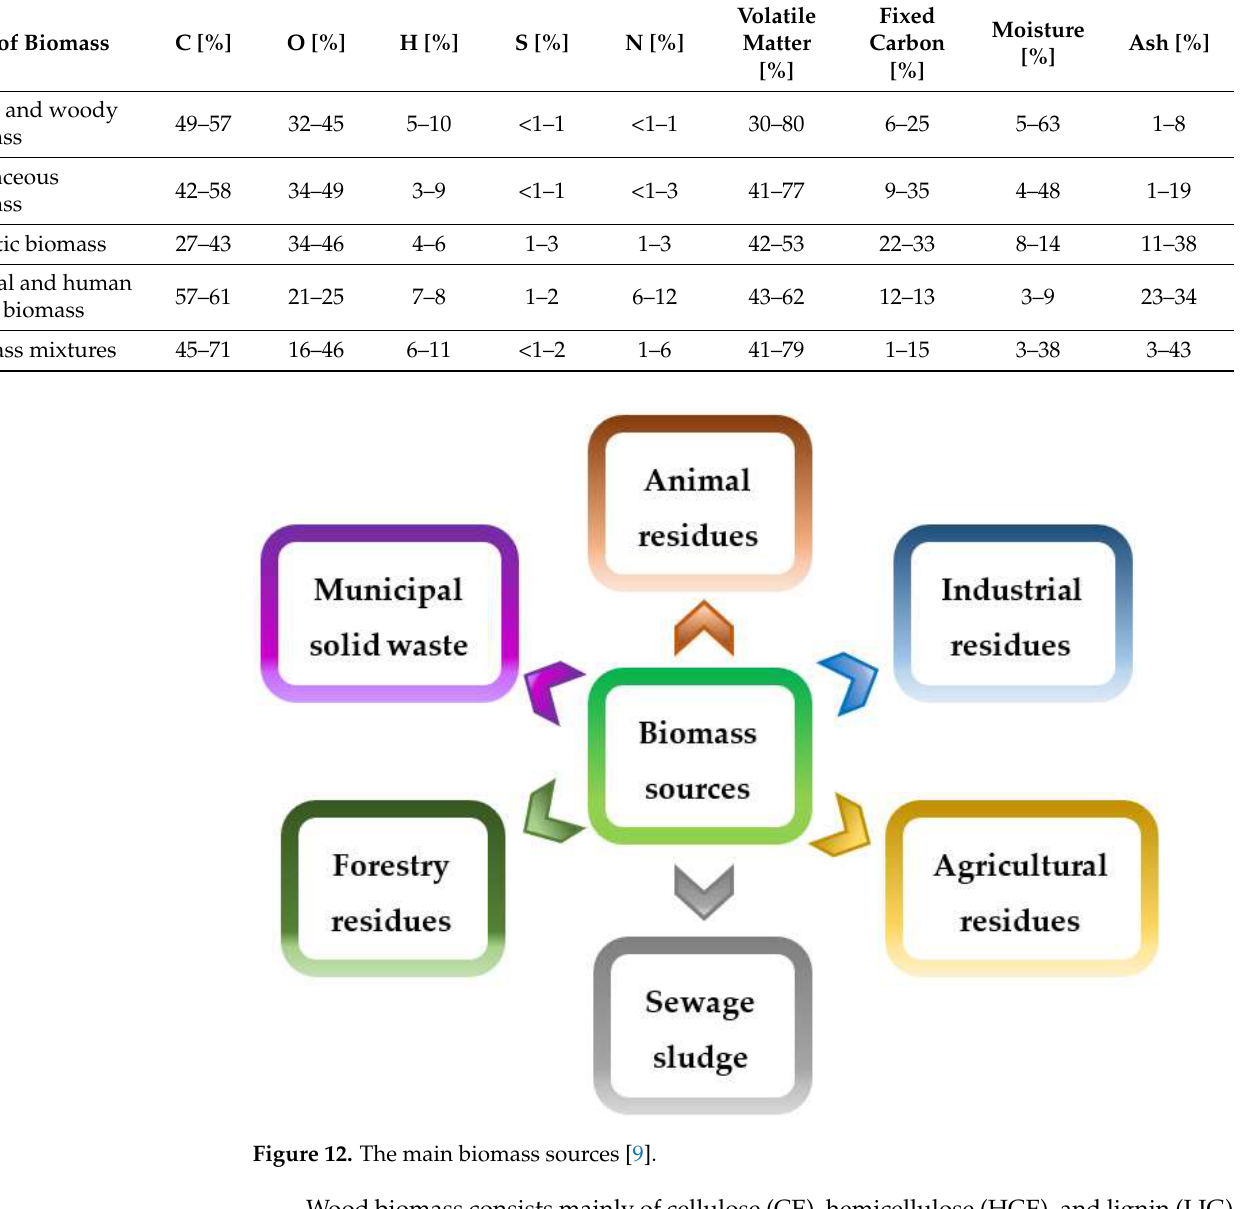
Table 2. Range of chemical composition of different types of biomass [39].